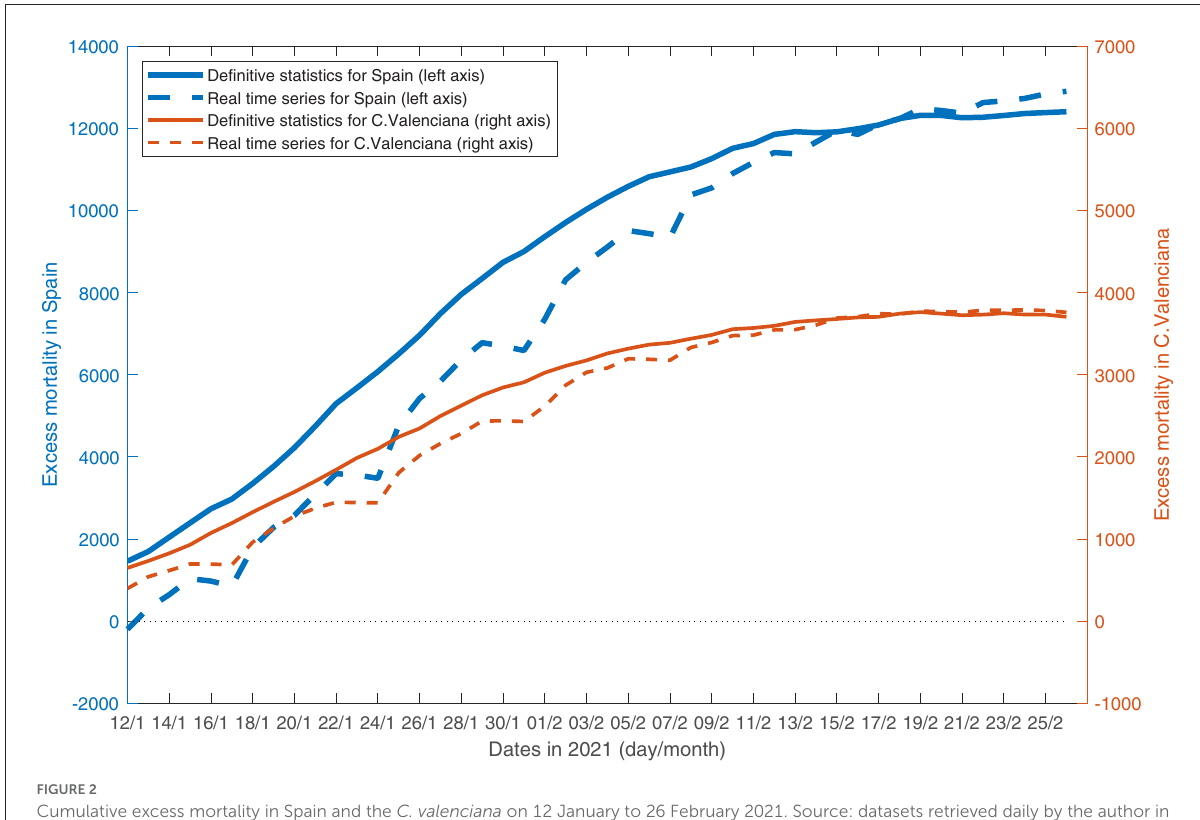
FIGURE2 Cumulative excess mortality in Spain and the C. valenciana on 12 January to 26 February 2021. Source: datasets retrieved daily by the author in that period from